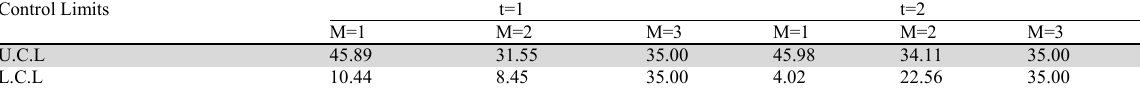
Control limits for each machine type in best observed solution Control Limits